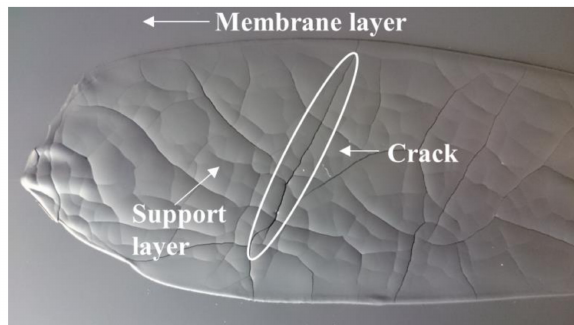
Figure 6. Green tape obtained by powder C after the sequential deposition of membrane and support layers using a reduced solid volume fraction ( slurry 1